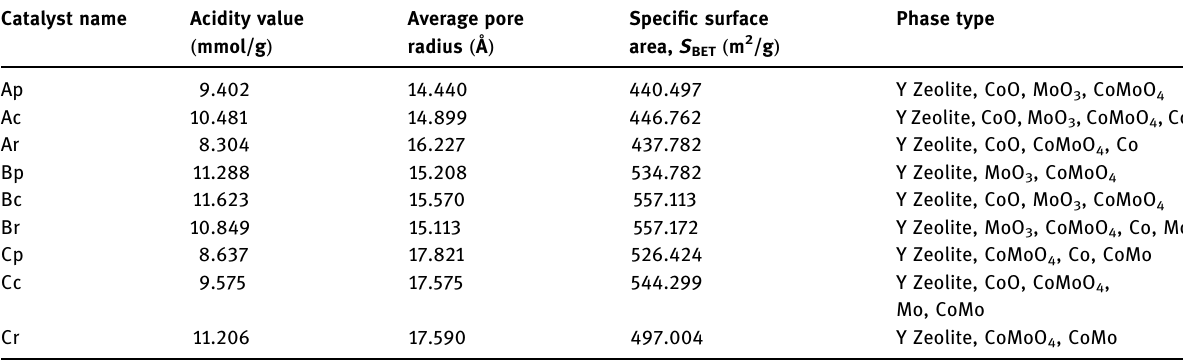
Table 2: Acidity value, speci fi c surface area, and phase type of catalyst Catalyst